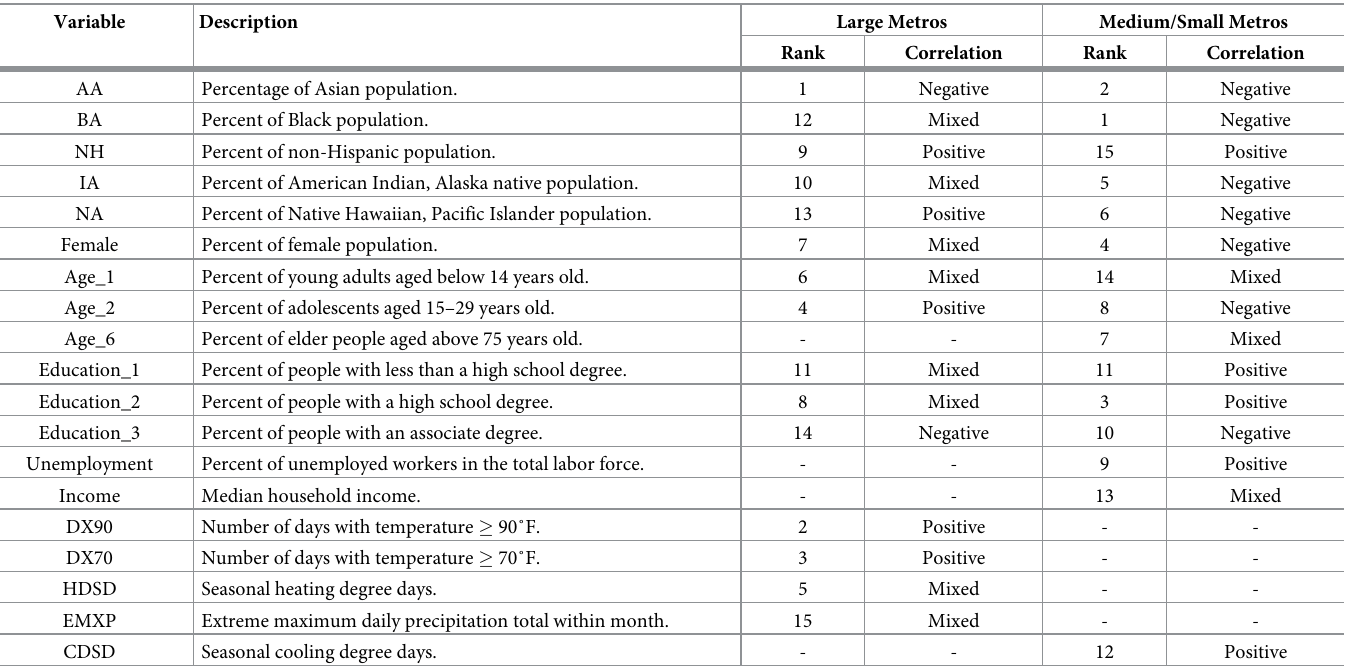
Table 5. Summary of top 15 variables in large and medium/small areas.